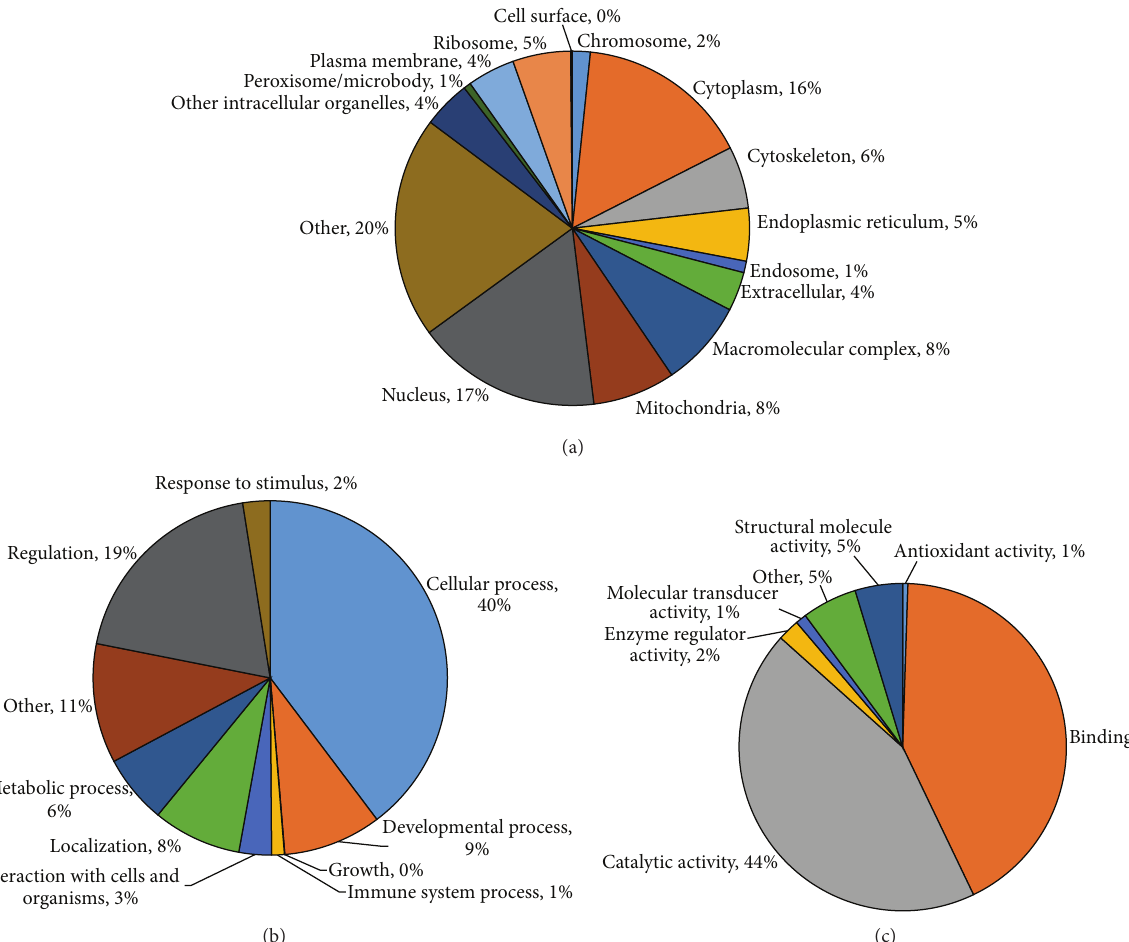
Figure 4: Distribution of proteins identified from the 2D shotgun dataset of DOC-extracted liver tumor samples based on (a) subcellular localization;(b)biologicalprocesses;(c)molecularfunctions.Atotalof4,790proteinswereusedinthisGOanalysisusingSTRAP.Percentages are rounded to the nearest whole